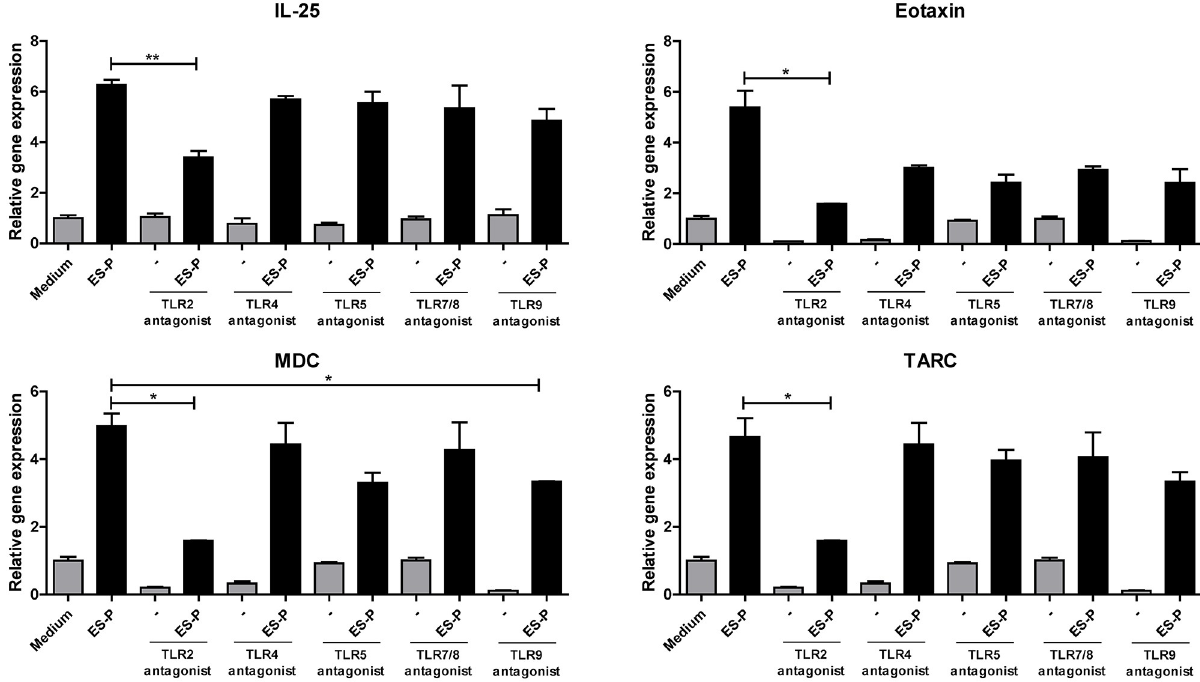
Fig 1. KA/E2 ES-P induced inflammatory-related gene expression by TLR2 in MLE12 cells. Comparison of the expression of inflammatory response-related genes in MLE 12 cells from the KA/E2 ES-P group or TLRs antagonist pre-treated group. (n = 3/group, 3 independent experiments, � ; p < 0.05, �� ; p < 0. 01, ��� ; p < 0.001).